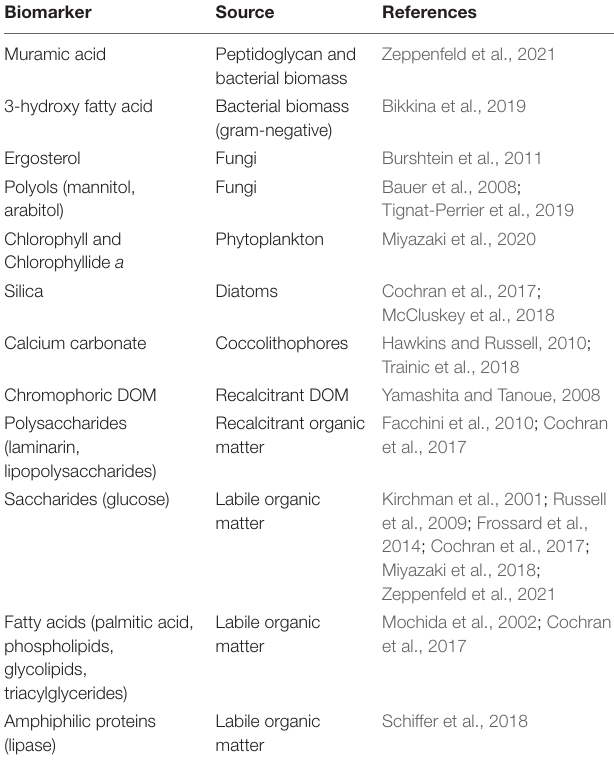
TABLE 2 | Potential biomarkers of different sources of organic matter and microorganisms in the